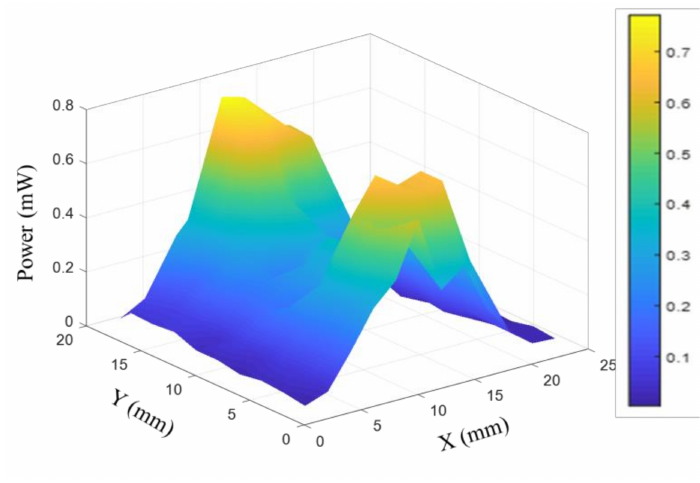
Figure 6. Relative distribution of power across horn antenna